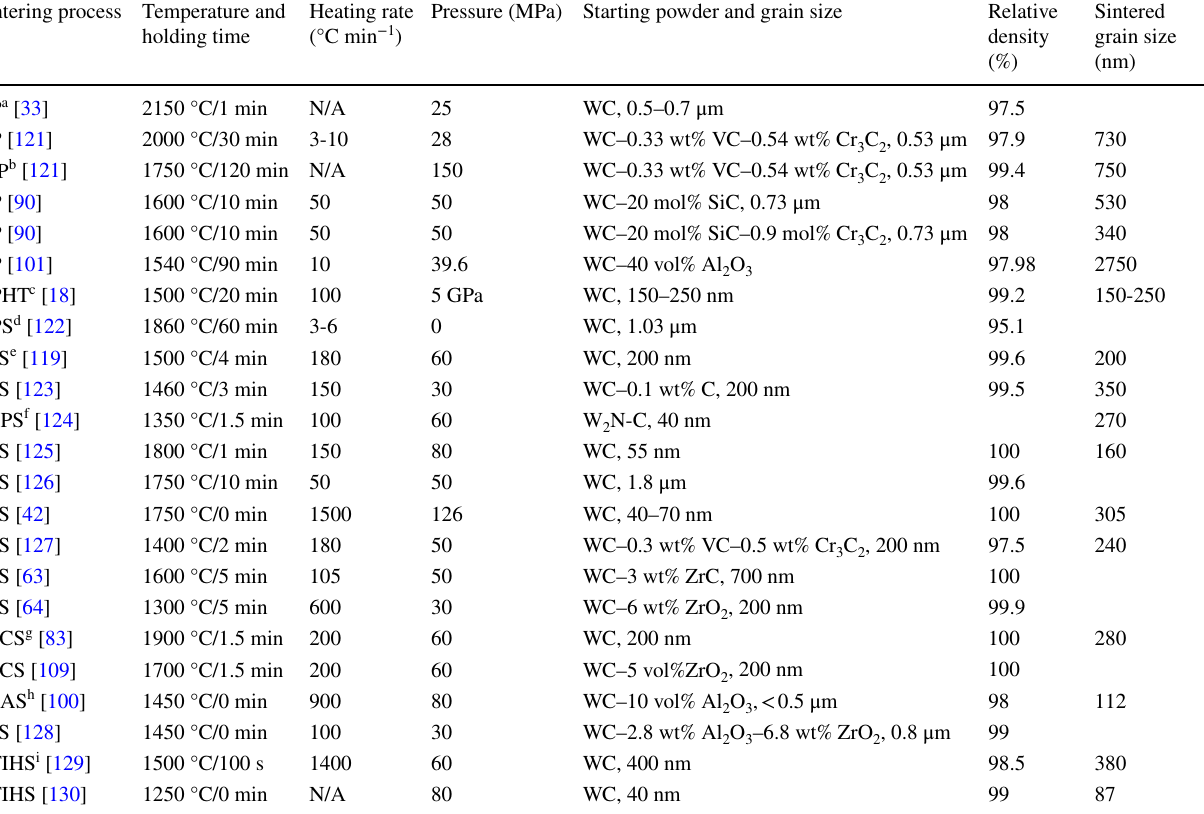
a Hot pressing; b Hot isostatic pressing; c HIgh pressure and high temperature; d Gas protection sintering; e Spark plasma sintering; f Reactive spark plasma sintering; g Pulsed electric current sintering; h Pulsed current activated sintering; i High frequency induction‑heated